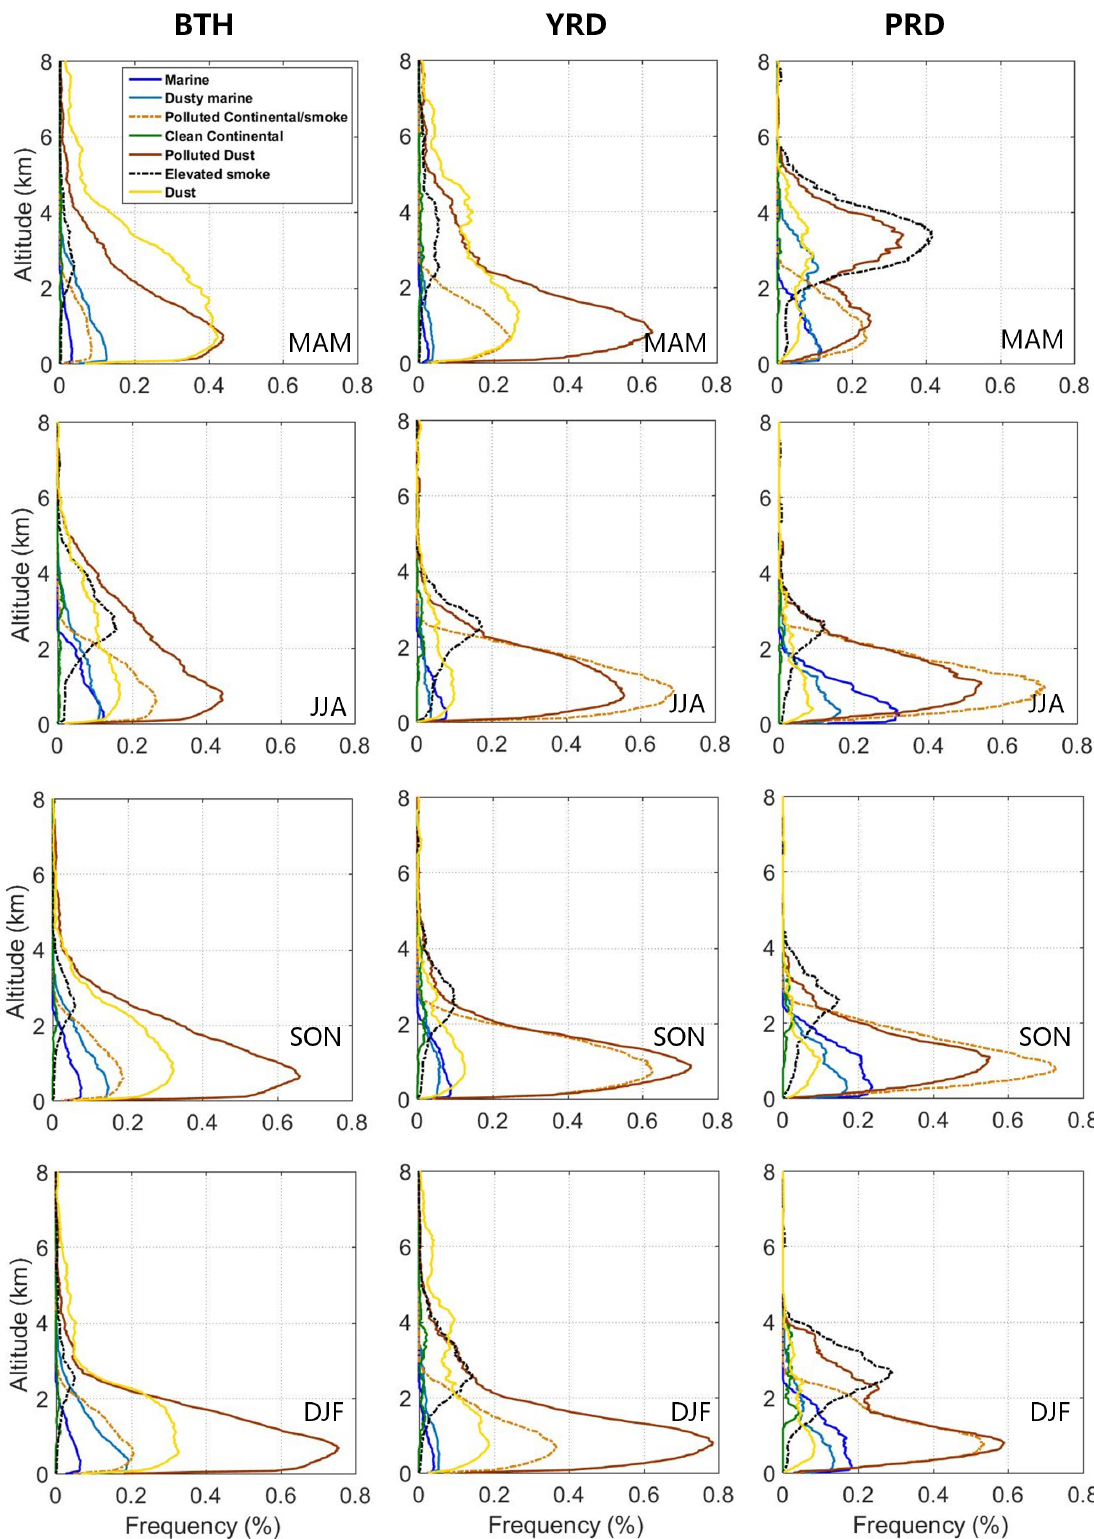
Figure 10. Vertical distribution of the FO of different CALIOP aerosol types (see legend) during daytime, for each season over the BTH (left), YRD (middle) and PRD (right), averaged over the years 2007–2020.